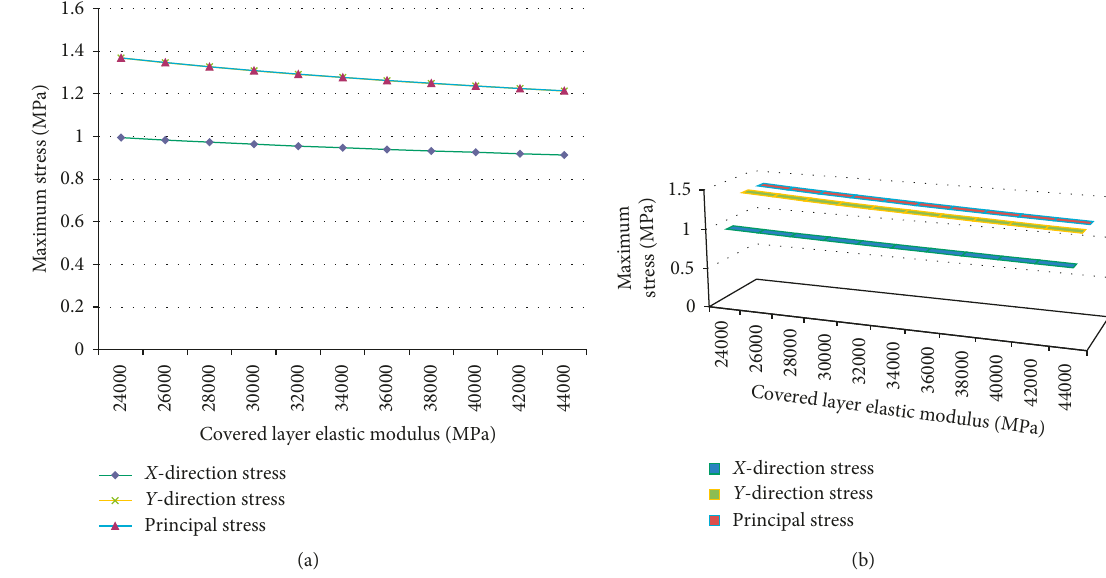
Figure 20: Variation of original surface layer stress with covered layer elastic modulus.